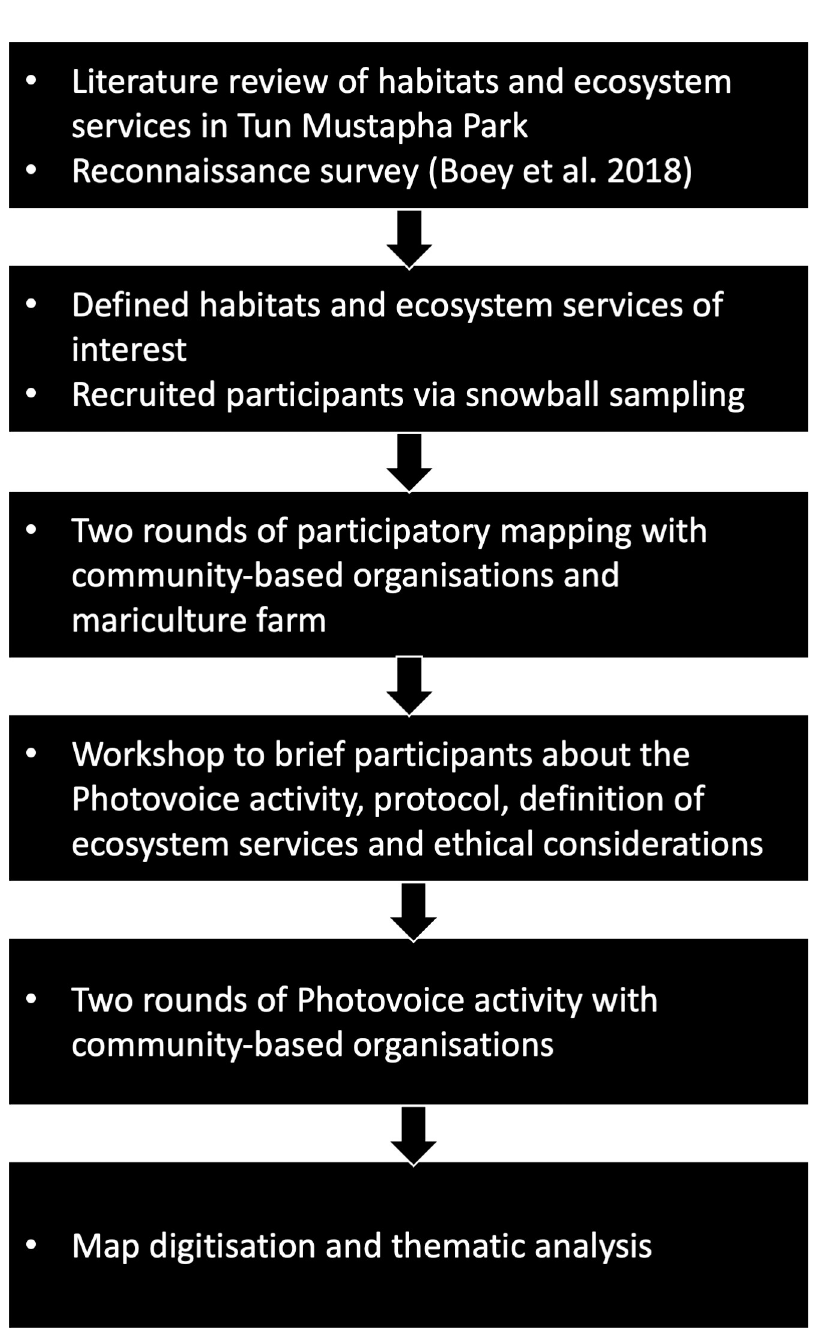
Fig 2. Workflow of this study in